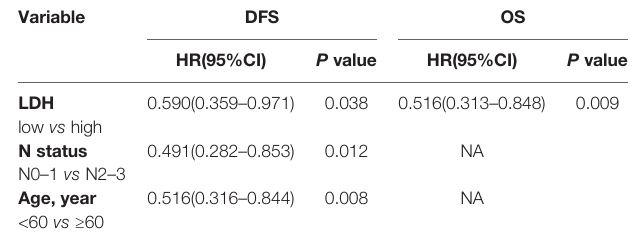
TABLE 6 | Survival analysis for patients with T1 – 2.